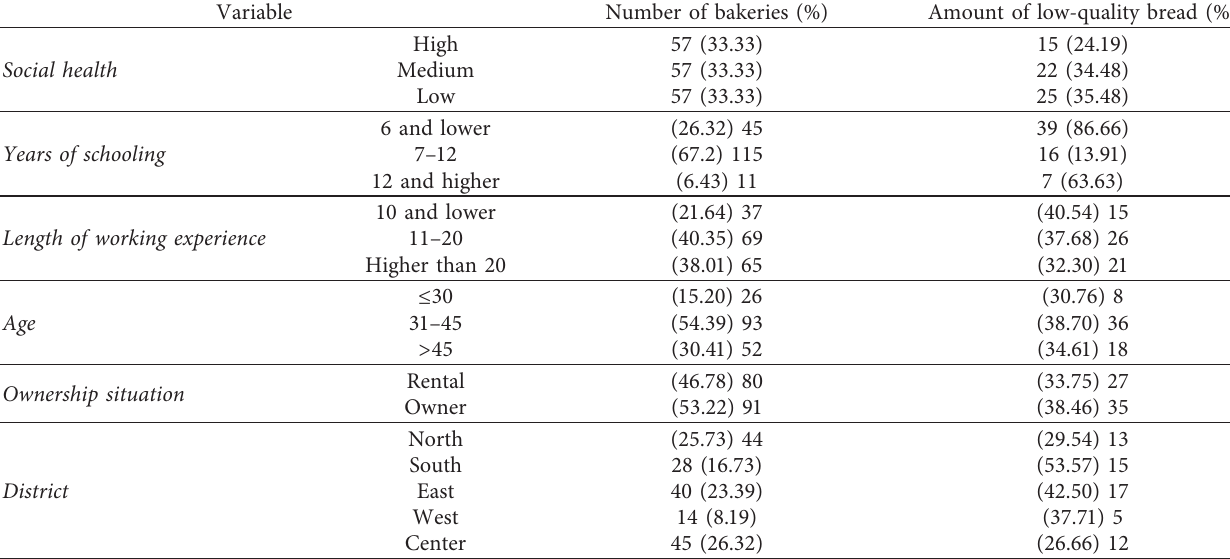
Table 1: Social health and demographic variables of bakeries and percentage of bakeries producing low-quality bread.